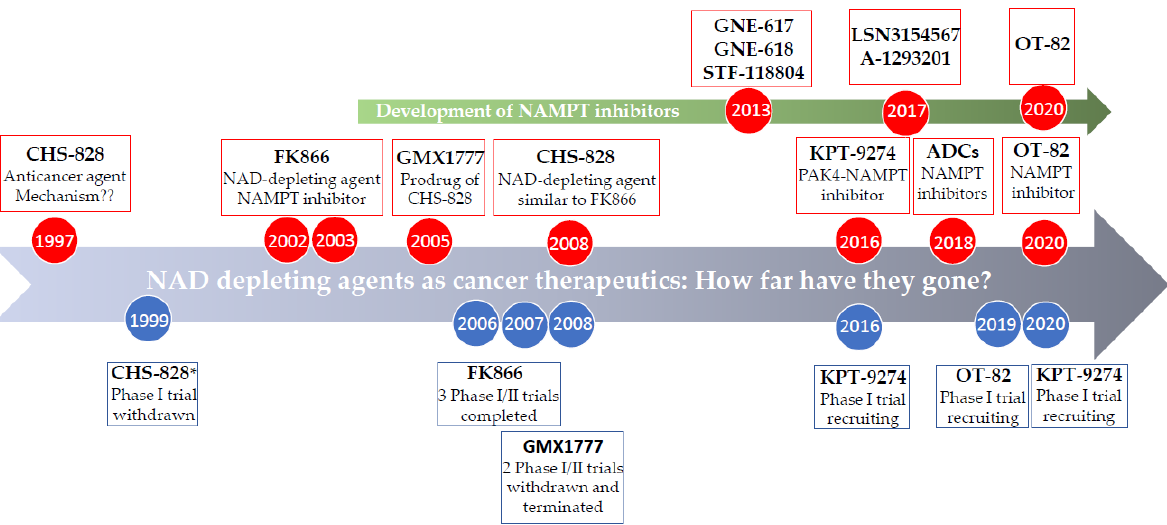
Figure 2. Timeline summary for the development of NAMPT inhibitors and their entry for evaluation in clinical studies. * the trial years are the years in which the study started according to clinicaltrials.gov.